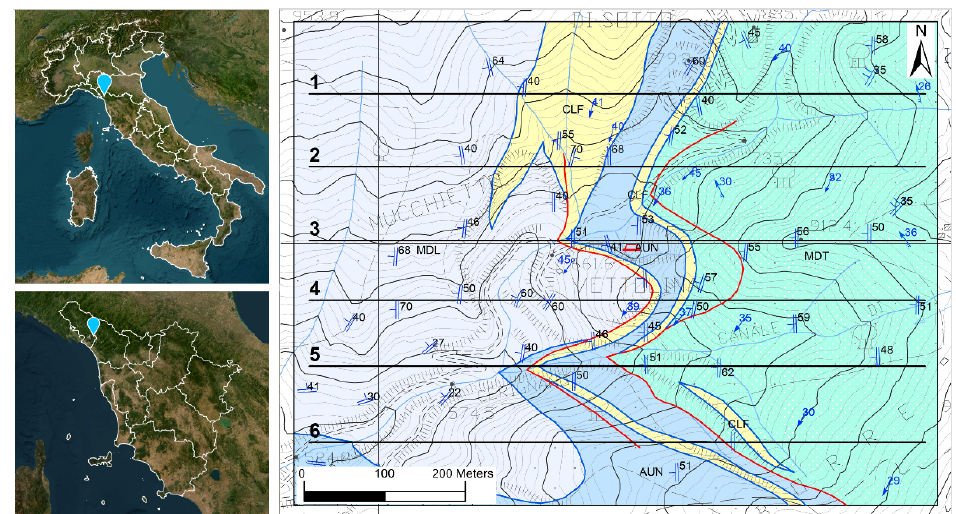
Figure 1. Geological map of the Sottovettolina quarry and surrounding area (right). Map legend is as follows: MDL—dolomitic marble; AUN—marble; CLF—cherty meta-limestone; MDT—radiolarian chert. The red symbol shows the quarry location. Red lines indicate tectonic boundaries of secondary importance. Black lines indicate the six traces of the geological sections used for the 3D modeling of the quarry area. Sketch maps in the left side show the location of the study area in Italy (light blue pin).